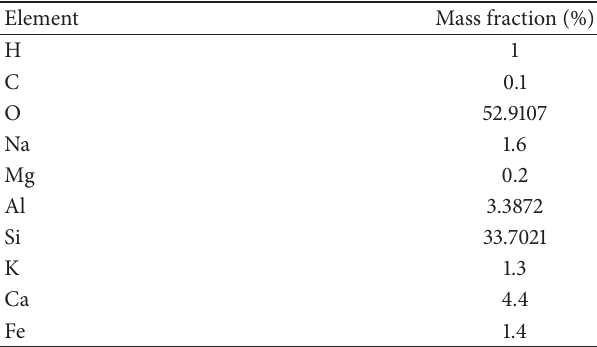
Table 2: Concrete sample parameters (density = 2.3 g ⋅ cm −3 ).